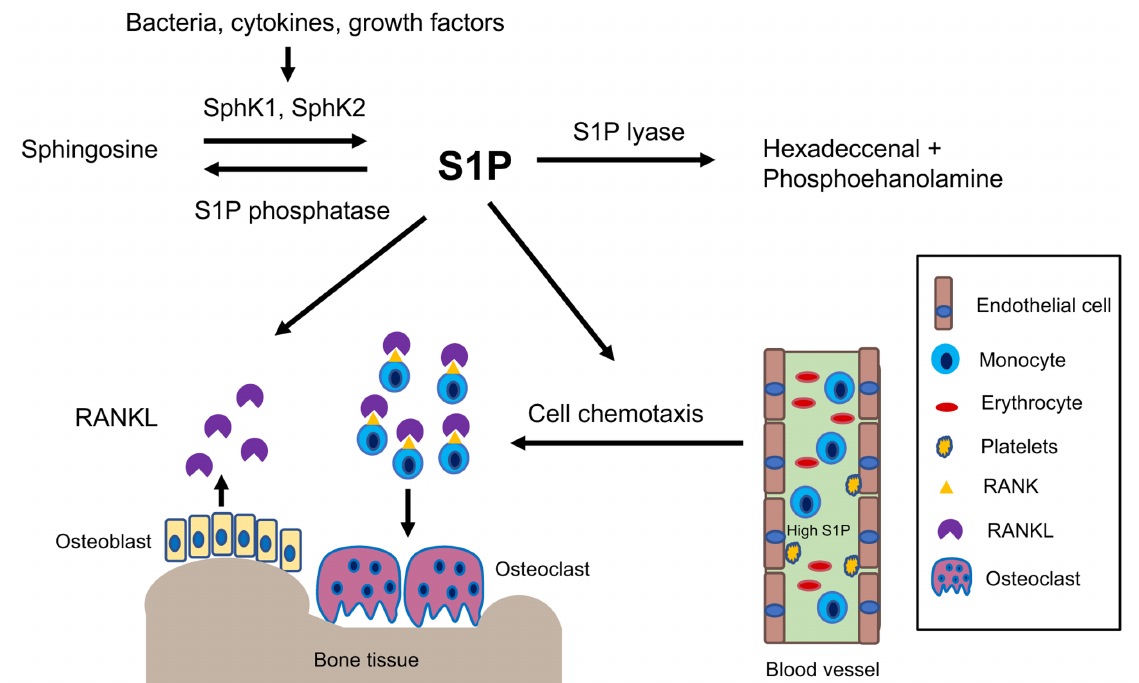
Figure 1. Simplified illustration of biological effects of S1P in inflammatory bone loss diseases. S1P is generated by activation of sphingosine kinases. S1P can be irreversibly degraded by S1P lyase or can be dephosphorylated by S1P phosphatase. S1P acts mainly as a chemokine to promote the chemotaxis of osteoclast precursors from blood circulation to bone and soft tissues. Additionally, S1P can induce RANKL production, which binds with RANK initiating